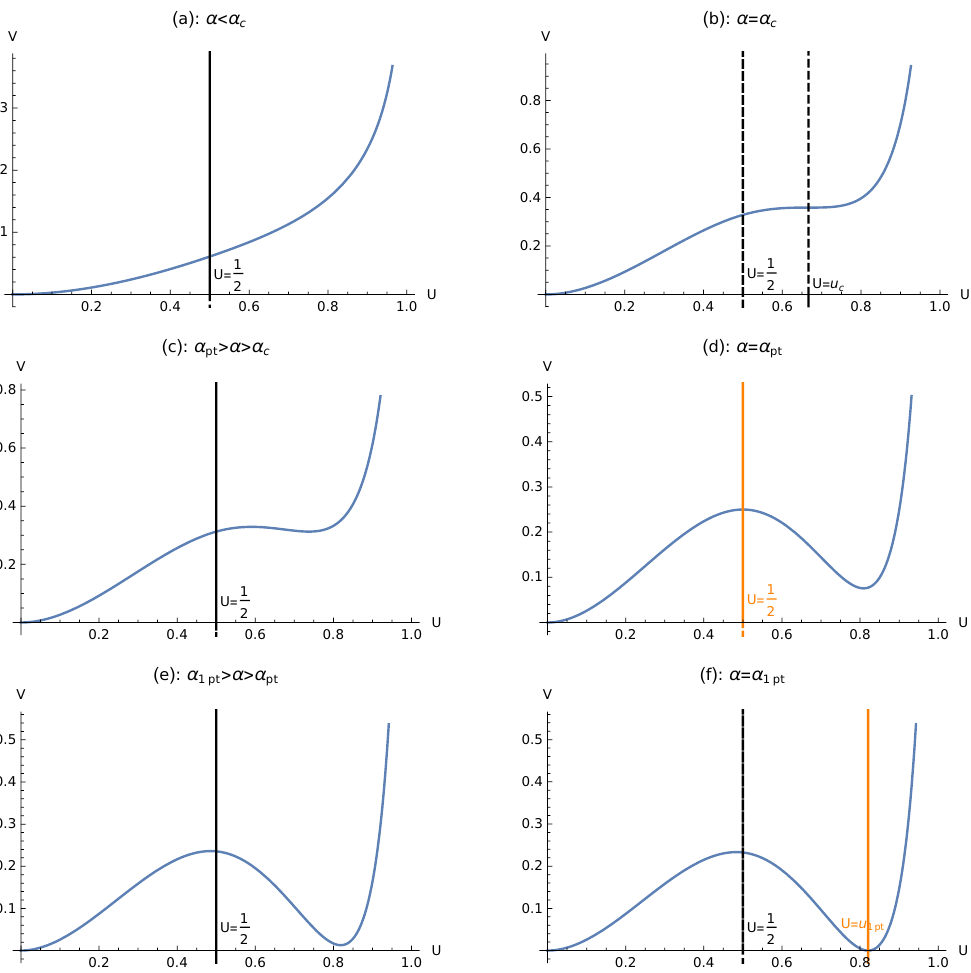
Figure 1 . E(cid:11)ective potential for di(cid:11)erent values of temperature and associated phase transitions. The graphs are drawn for q =